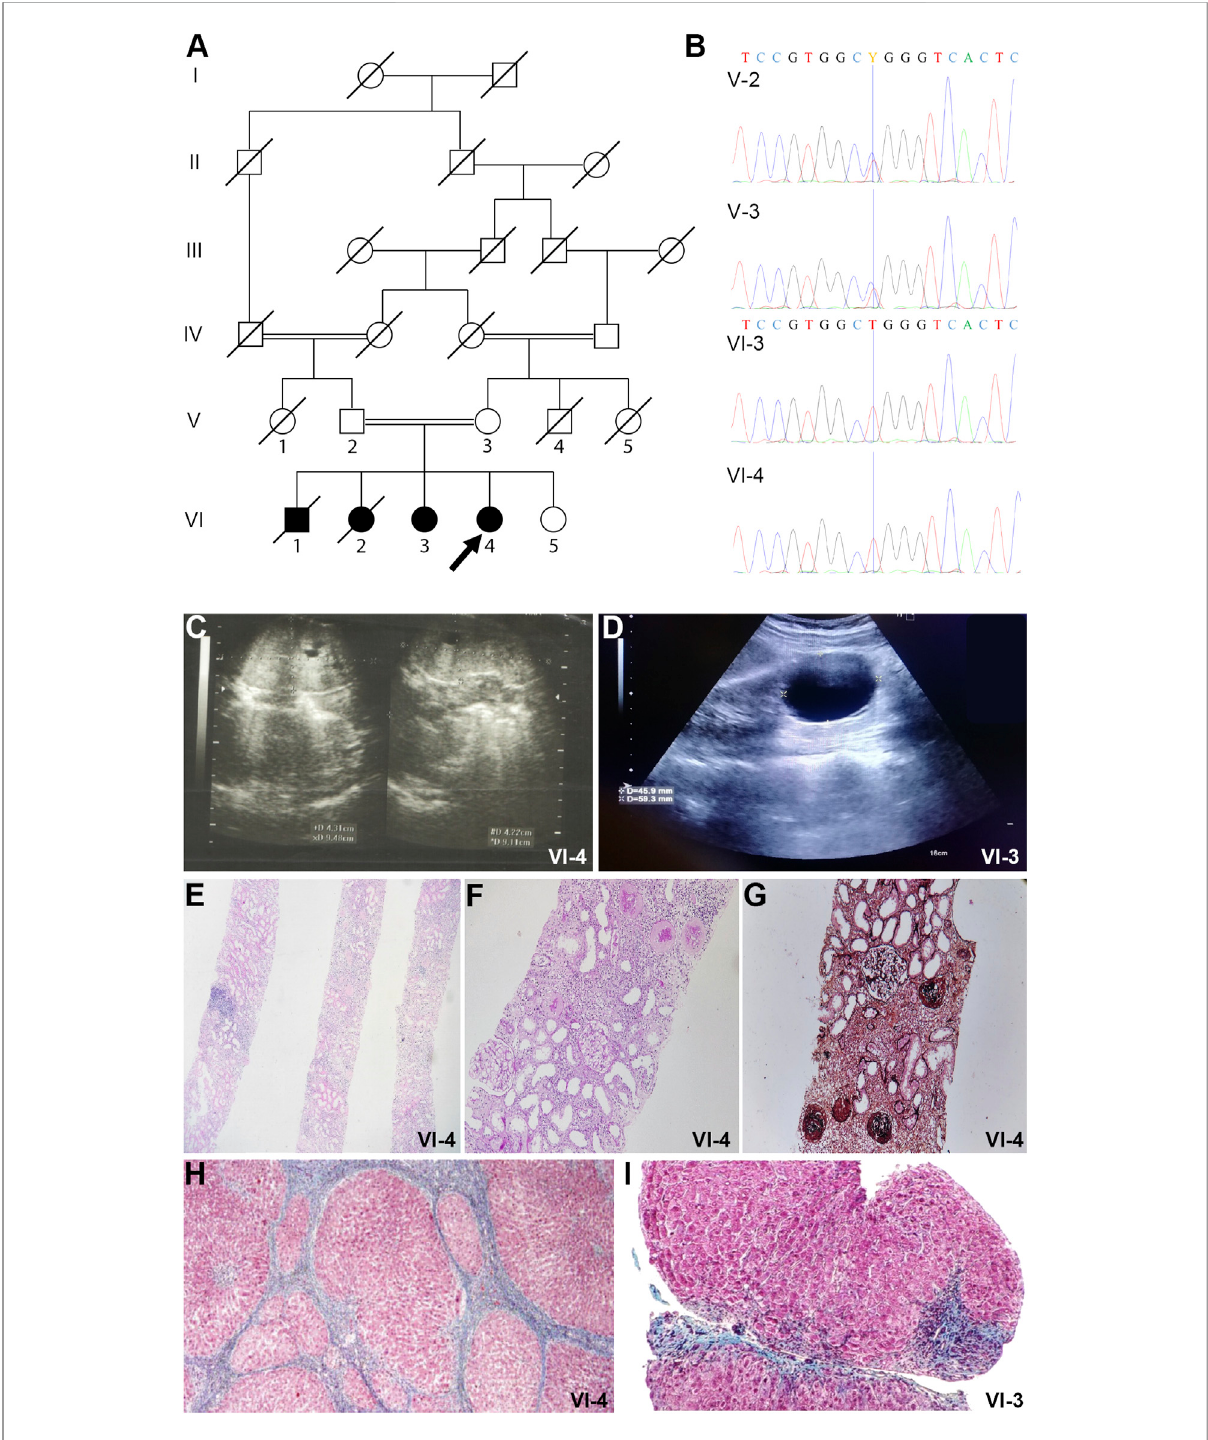
Pedigrees and imaging studies of TULP3 patients. (A) . Pedigree of the family. The pedigree of the family illustrates the recessive inheritance of the pathogenic variant in the family. Double lines in pedigrees indicate consanguinity. Filled and un fi lled circles/squares represent affected and unaffected individuals respectively, while circle/squares with diagonal lines indicate deceased individuals. Proband is VI-4 (arrow). (B) Electropherogram of the family. The homozygous variant in the proband (individual VI-4) and her sister (individual VI-3). The heterozygous variant in their parents (individual V-3 and V-4). Missense variant c.1144C > T results in alteration of Arginine to Tryptophan in position 382 of the TULP3 protein. (C) Abdominopelvic Sonography of patient VI-4. Kidney ultrasonography of the patient shows enlarged kidneys and several small cysts. (D) Abdominopelvic Sonography of patient VI-3. There is a simple cortical cyst measuring 45 × 59 mm in the mid pole of the left kidney. (E)